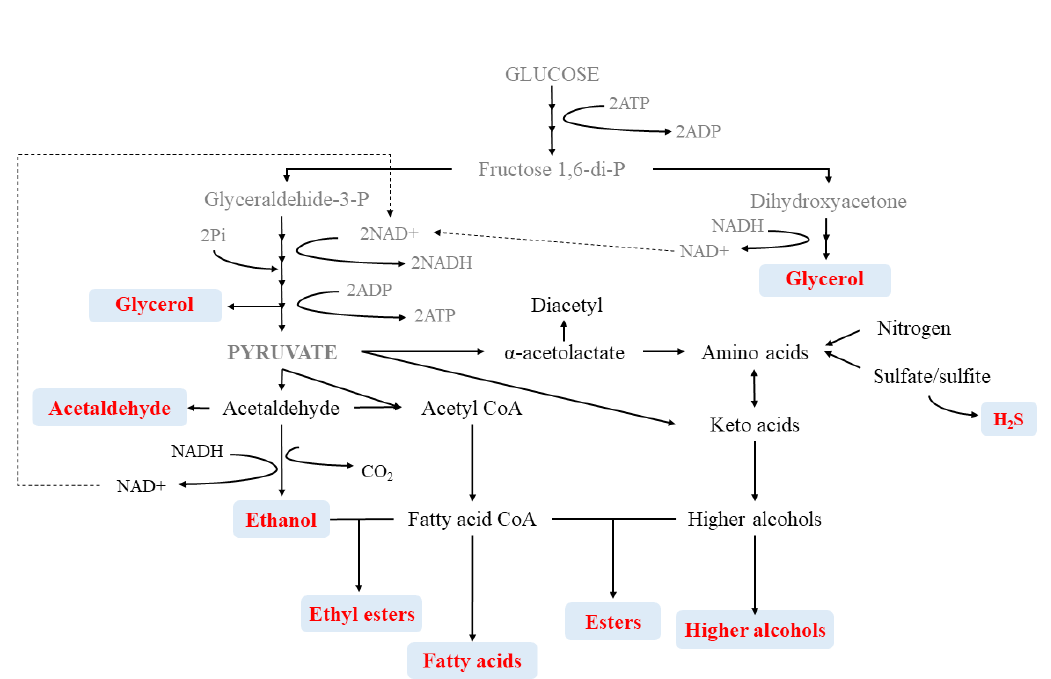
Figure 3. General representation of aroma compound metabolism.